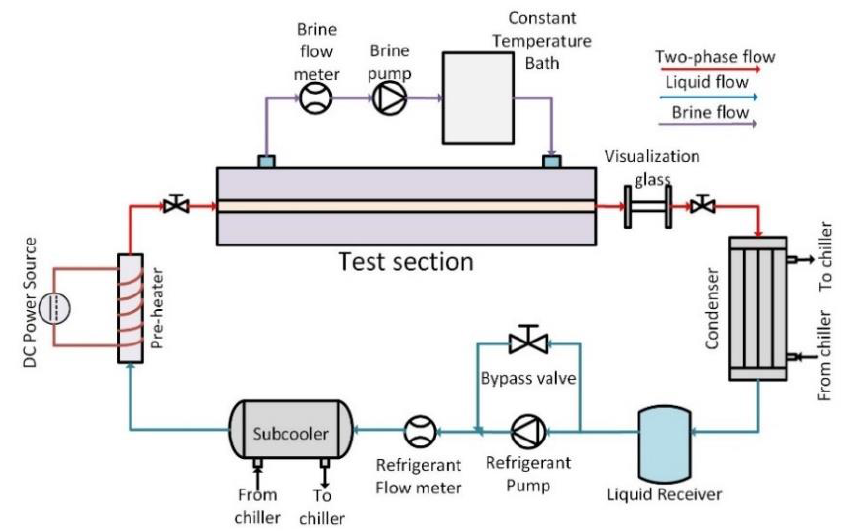
Figure 1. Schematic diagram of the experimental system.